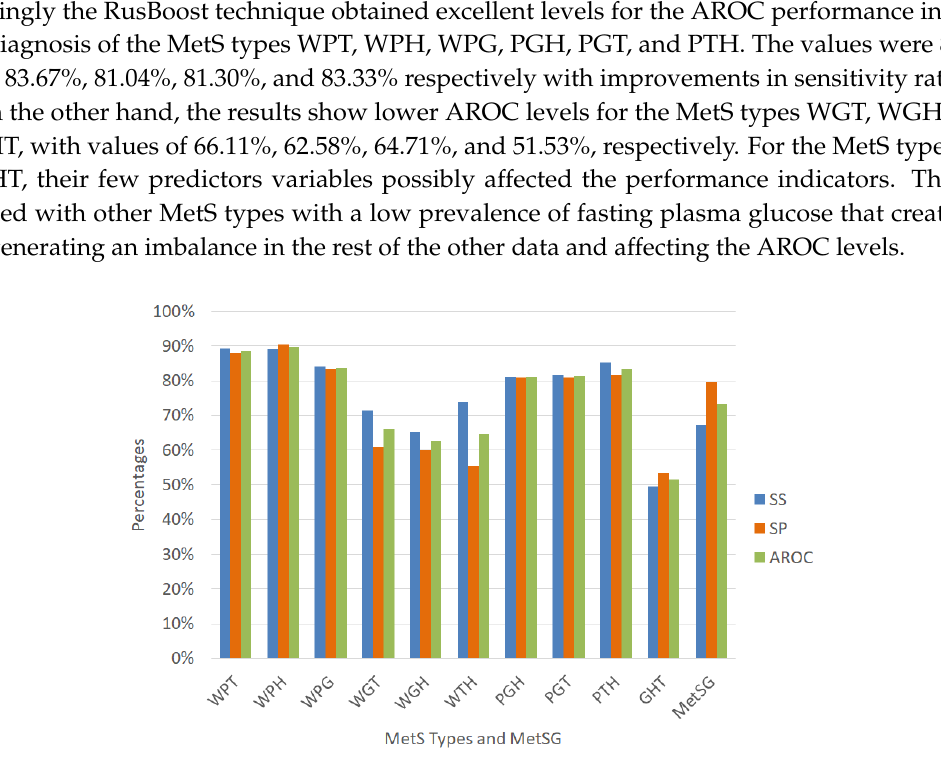
Figure 9. We called the new dataset of 799 samples as dataset with